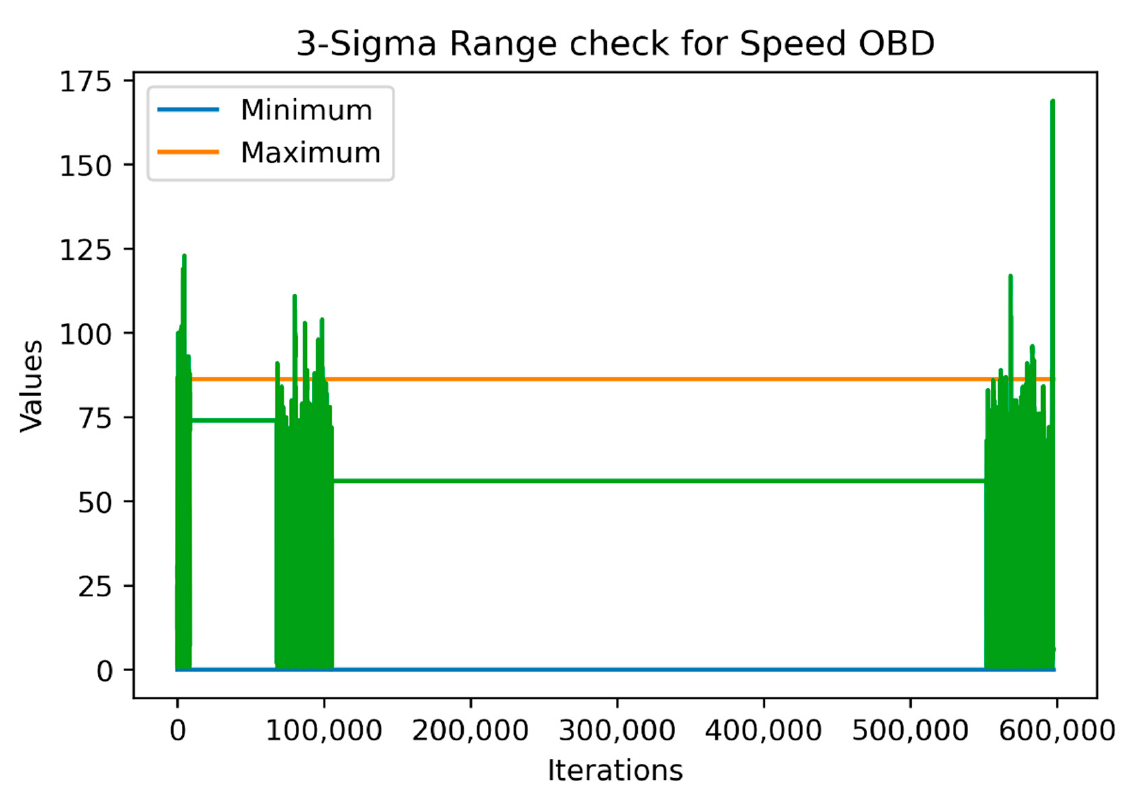
Sensors 2022 , 22 , x FOR PEER REVIEW 9 of 11 Figure 2. Simple range check based on the historical data. Figure 2. Simple range check based on the historical data.